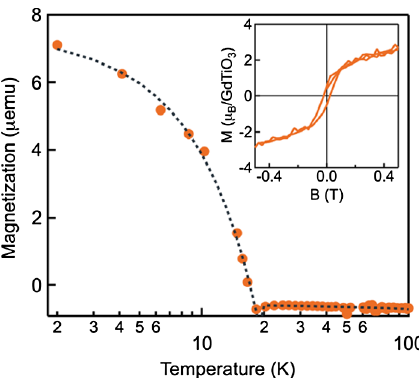
FIG. 2. Magnetization as a function of temperature at 10 mT for a 4 - nm GdTiO 3 = 1 - nm SrTiO 3 = 4 - nm GdTiO 3 = LSAT heterostruc- ture. The dotted line is a guide to the eye. The inset shows the magnetization M as a function of magnetic field at 2 K for the = 1 - nm SrTiO = LSAT heterostructure [same sample as shown in Fig. 8 - nm GdTiO 3 3